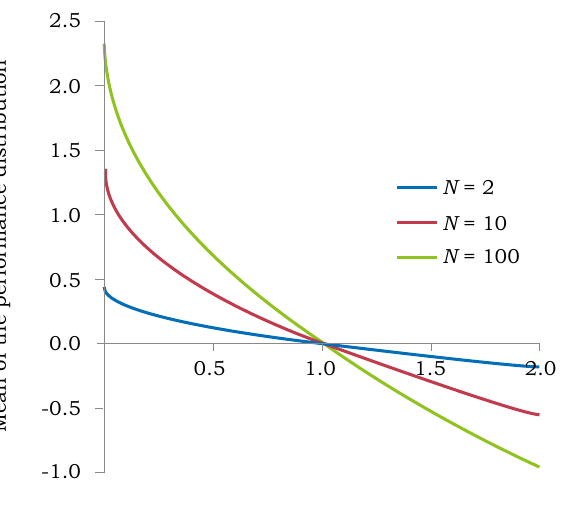
Figure 1. Competitive equality